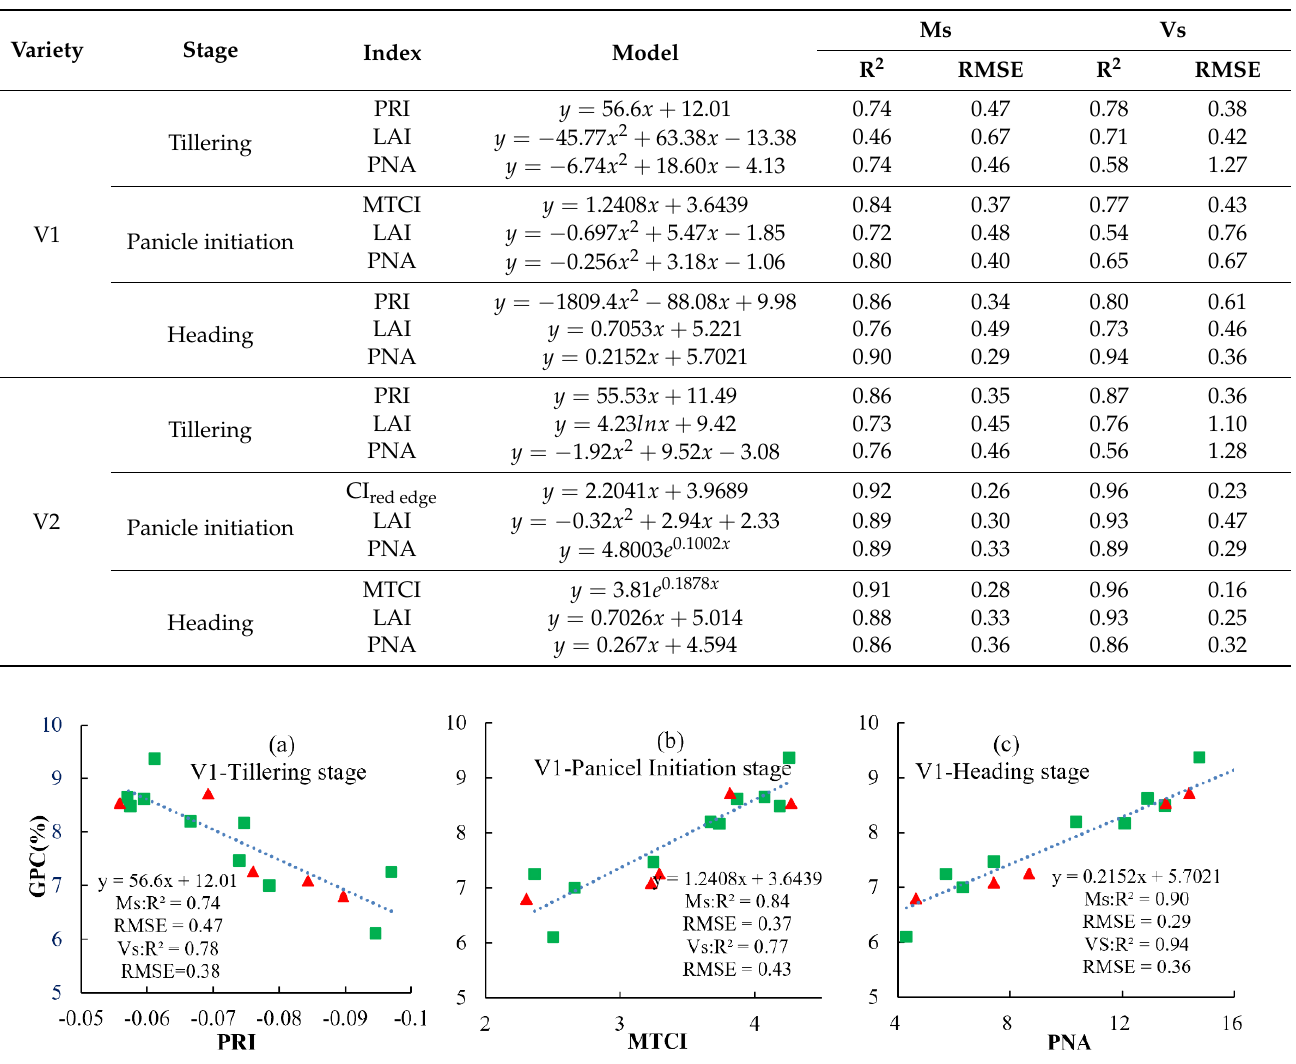
Table 8. Rice grain protein content (GPC) estimation models based on single-factor index parameters and their accuracy ( n = 15).